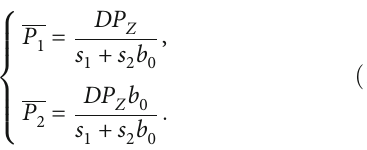
Figure 7: Mechanical model of the solid coal side of the retracement